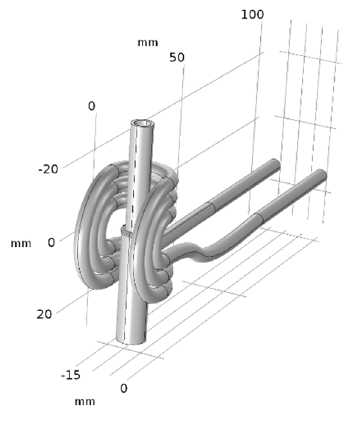
Figure 1. Model geometry.